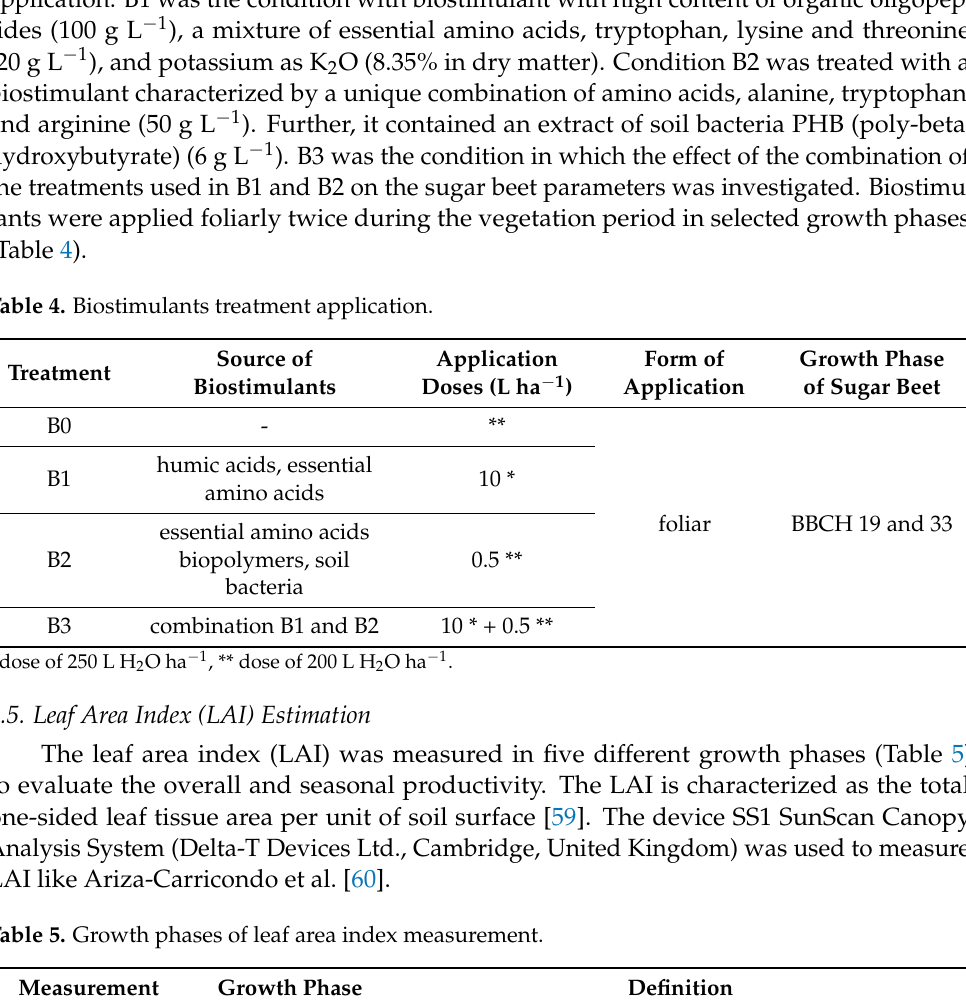
Application Doses (L ha − 1 )